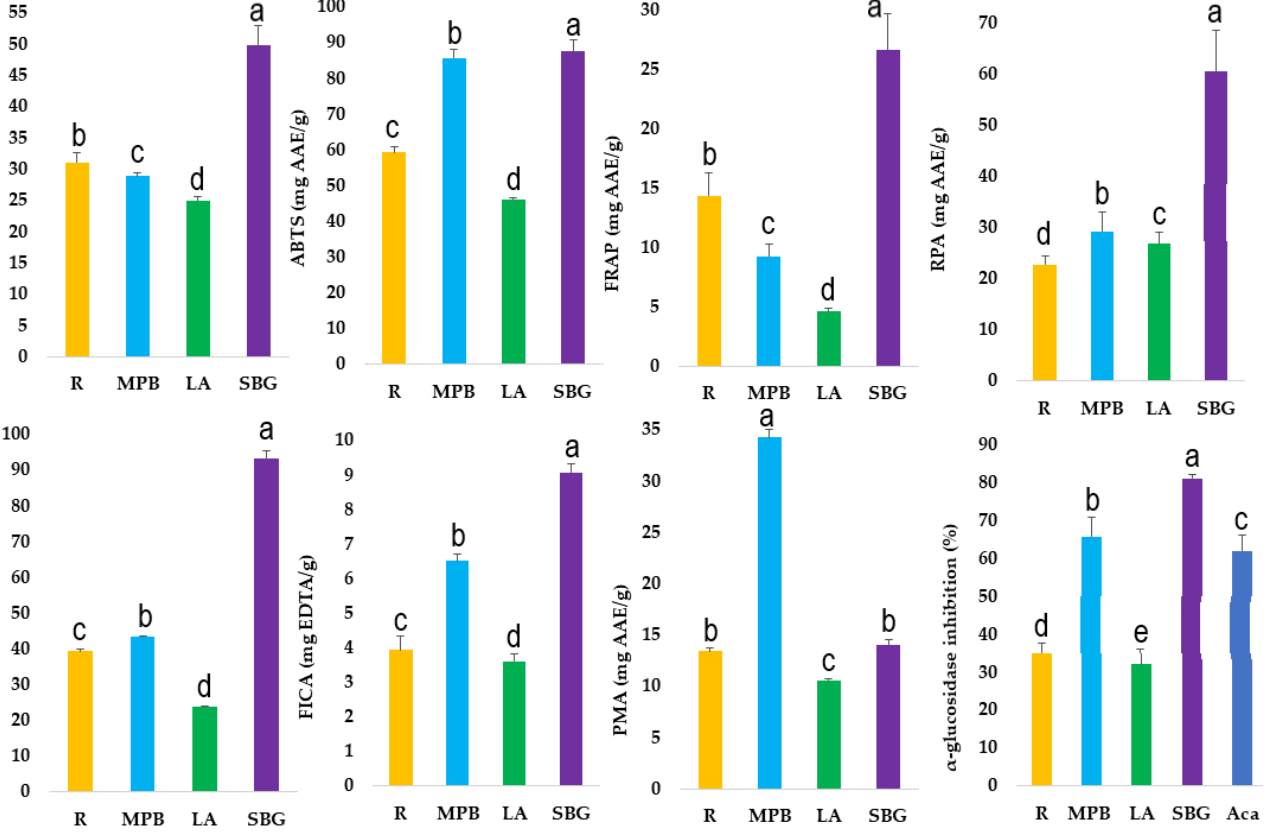
Figure 1. Biological activities (2,2 ′ -diphenyl-1-picrylhydrazyl (DPPH), 2,2 ′ -azinobis-(3-ethylbenzo- thiazoline-6-sulfonic acid (ABTS), ferric reducing antioxidant power (FRAP), reducing power as-